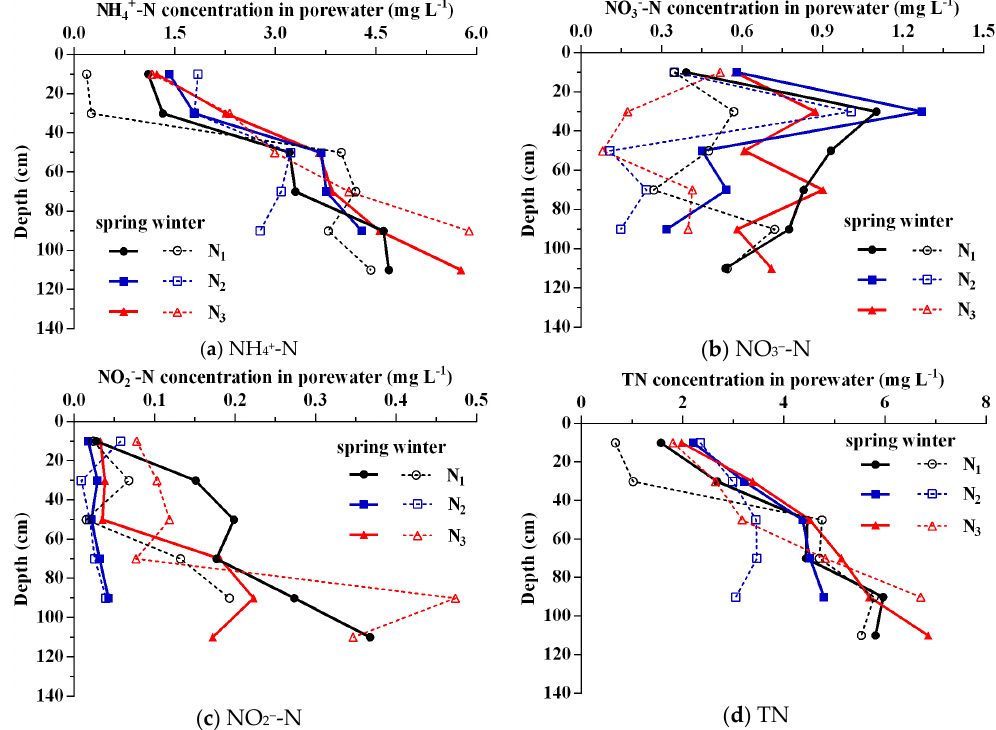
Figure 5. Vertical profiles of nitrogen in the porewater of the hyporheic zone at the north sites in Lake Taihu during spring and winter 2016.